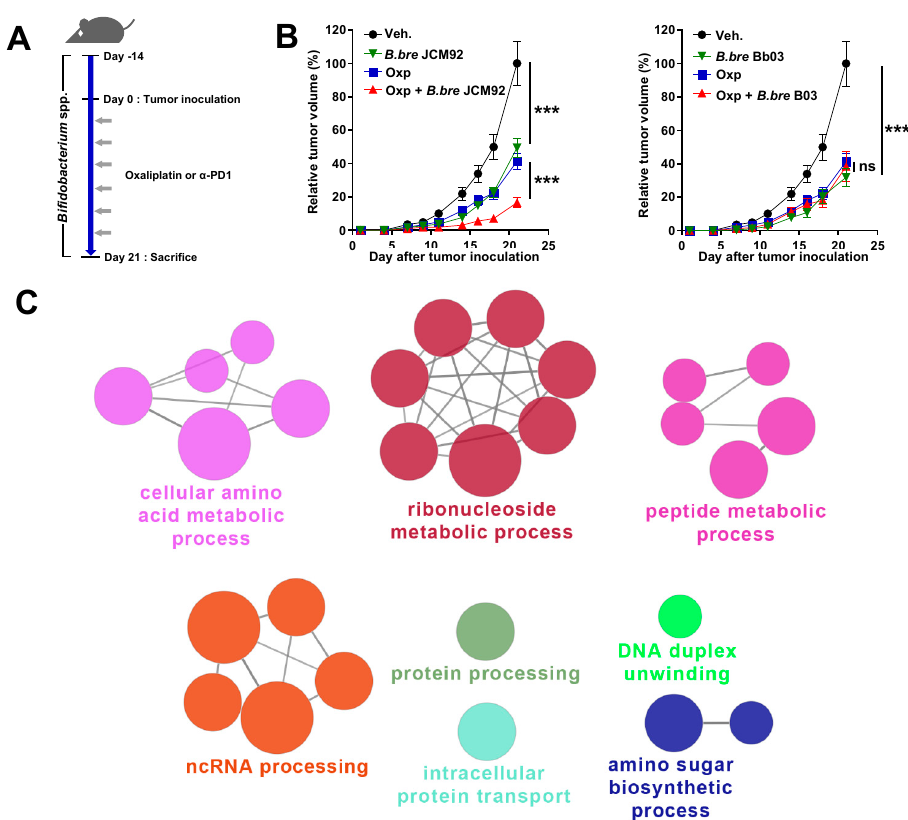
Figure 1 . Supplementation of Bifidobacterium strains exhibits anti-tumor effects. ( A ) Experimental protocol: each Bifidobacterium strain was administered orally 14 days before MC38 inoculation and continued until the end of the experiment. After tumor inoculation, oxaliplatin or PD-1 blockade was injected intraperitoneally. ( B ) Tumor growth curves after administering Bifidobacterium strains, with or without oxaliplatin. Oxp, oxaliplatin; B. bre JCM92, B. breve JCM92; B. bre Bb03, B. breve Bb03. Data are expressed as the means ± standard error of means (SEM). p -values were determined by two-way ANOVA using Tukey’s post-test. ( C ) Representation of the ClueGO functional network analysis of the upregulated genes in B. bre JCM92 compared to B. bre Bb03 (Fold change > 2). *** p < 0.001, and ns, not significant.